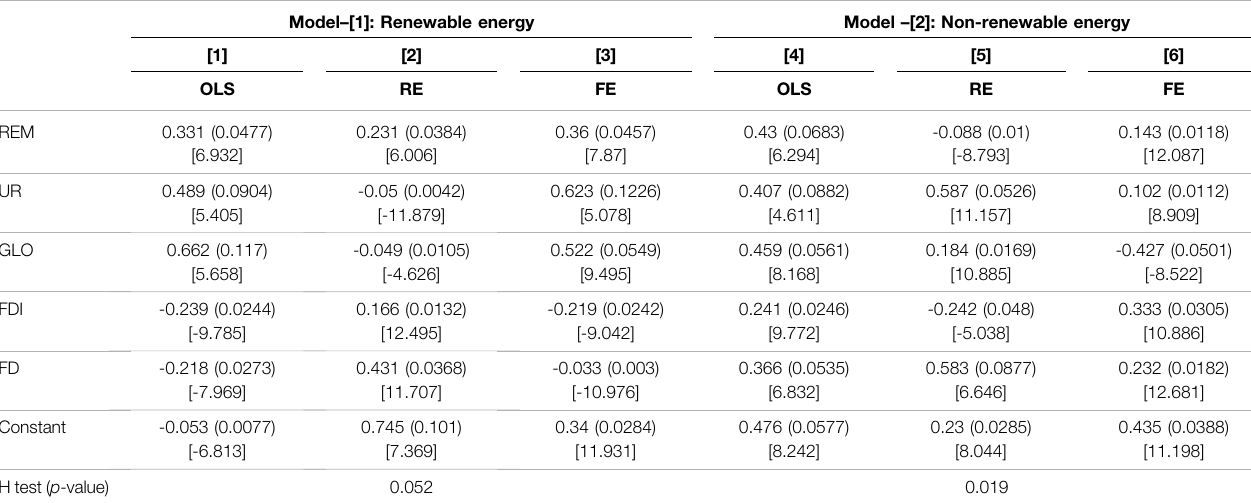
TABLE 5 | Results of baseline model estimation.